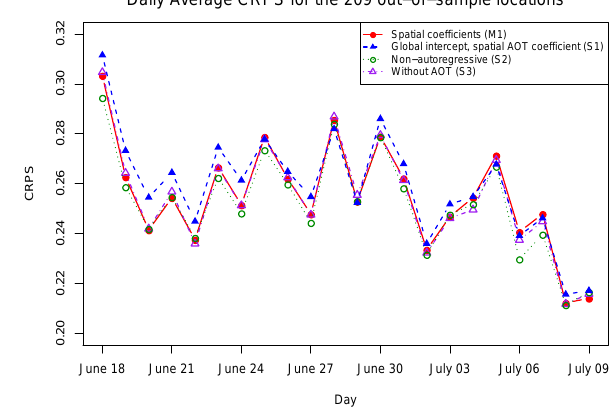
Figure 8. Daily average CRPS for the out-of-sample locations un- der the competing